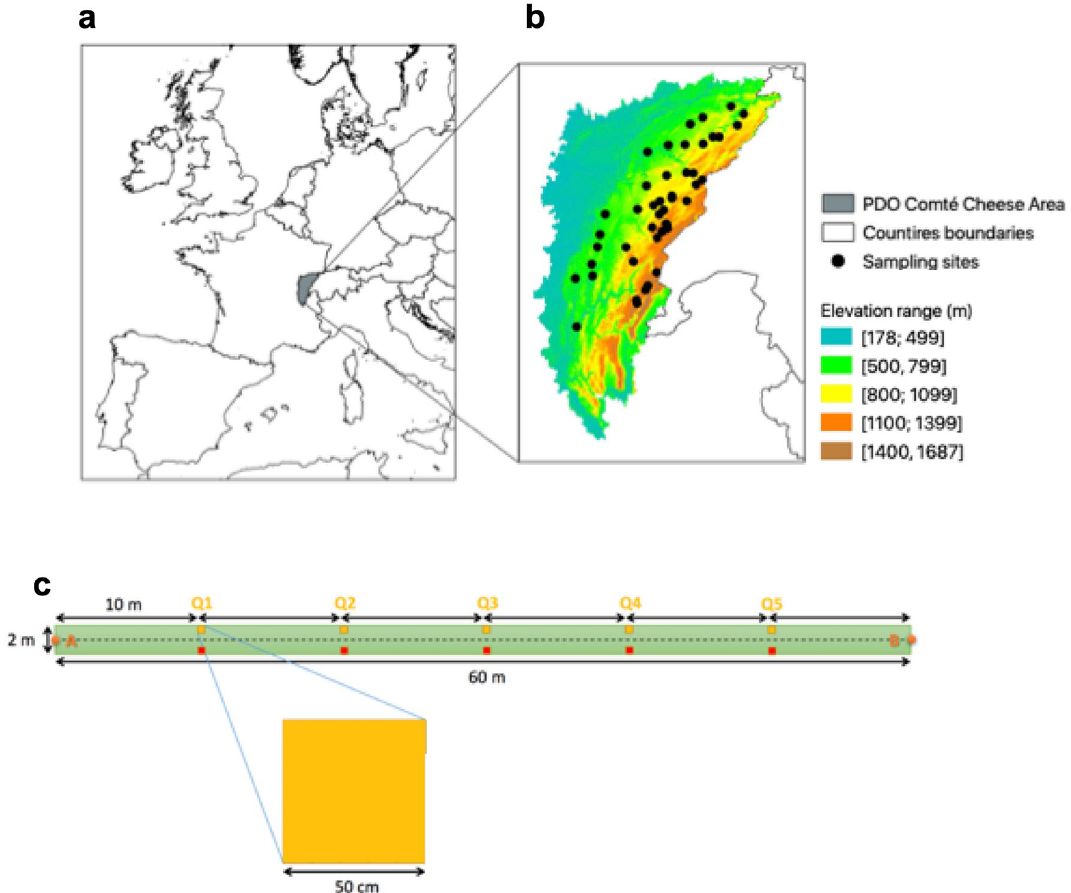
Figure 4. Farm network distribution across the PDO Comté cheese area in the Jura mountains. ( a ) Location of the PDO Comté cheese area. ( b ) Distribution of each farm (black dots, n = 44) in the Jura Mountains. Color gradient provide the elevation information. ( c ) Organization of the sampling area in each grassland showing locations of soil and microbial sampling (red) and quadrats for detailed vegetation records (yellow). Maps in ( a ) and ( b ) were generated under QGis 53 , version 3.12. Background is based on: administrative limits of European countries (https:// ec. europa. eu/ euros tat/ fr/ web/ gisco/ geoda ta/ refer ence- data/ admin istra tive- units- stati stical- units/ count ries) in ( a ); RGE Alti 75 m database (https:// geose rvices. ign. fr/ rgeal ti) in ( b ). Both databases are open (Fig. 4C). Within each subplot of the first series, soil and phyllosphere were sampled using the following proce- dures. The second series was used for detailed vegetation records. Second, cow-teat surface and milk samples were collected in the milking parlour on cows grazing the selected grassland parcel. For this, at least 10 dairy cows were randomly selected within the herd. Third, the plant community was described over the whole sampling plot (120 m 2 ) to account for a maximum of plant species, which is common in studies of permanent grasslands 34,54–56 . All vascular plant species observed in the sampling plot were listed and their cover was estimated according to the Braun-Blanquet dominance scale (r, +, 1, 2, 3, 4, 5). These codes were then converted into absolute percentage cover 55 and adjusted to relative percentage cover by summing to 100% for each plot. Based on these measures, taxonomic diversity was measured through species richness (SpRichness), Pielou evenness 57 .